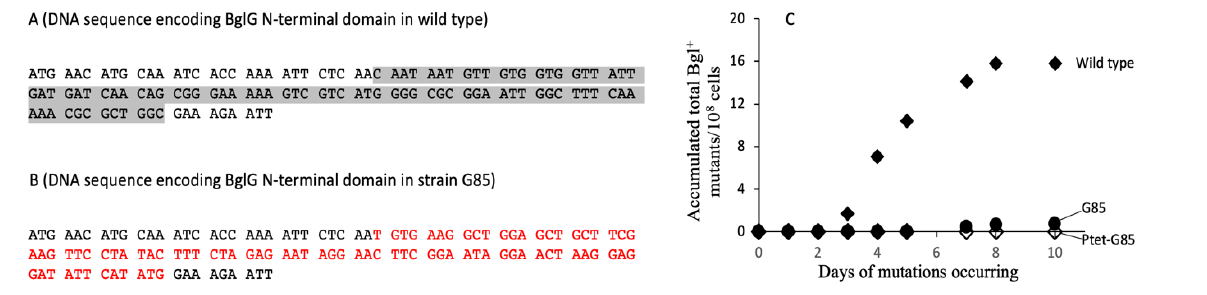
Figure 5. N-terminal domain of BglG is required for enhancement of Bgl + mutations. ( A ) DNA sequence of the portion of bglG encoding BglG’s N-terminal domain in the wild type protein. ( B ) DNA sequence of the portion of bglG corresponding to the altered N-terminal domain of BglG in strain G85. The 85-bp DNA region in grey ( A ) that encodes 28 N-terminal residues of BglG was replaced by an 85-bp DNA scar (red-faced nucleotides) in ( B ). This 85-bp scar is in frame within the bglG gene and has no stop codon. ( C ) Bgl + mutation assays using strain G85 without or with bglG overexpression. Strains G85 (with the altered 28 residues at N-terminal residues of the native BglG) and Ptet-G85 (with the intact bglG in native bgl operon plus P tet driving bglG85 at the intS locus of BW25115) were subject to Bgl + mutation assays as described in the legend to Figure 1 and the “Materials and Methods” section. Solid diamonds: wild type bglG ; solid circles: G85; open diamonds: Ptet-G85.